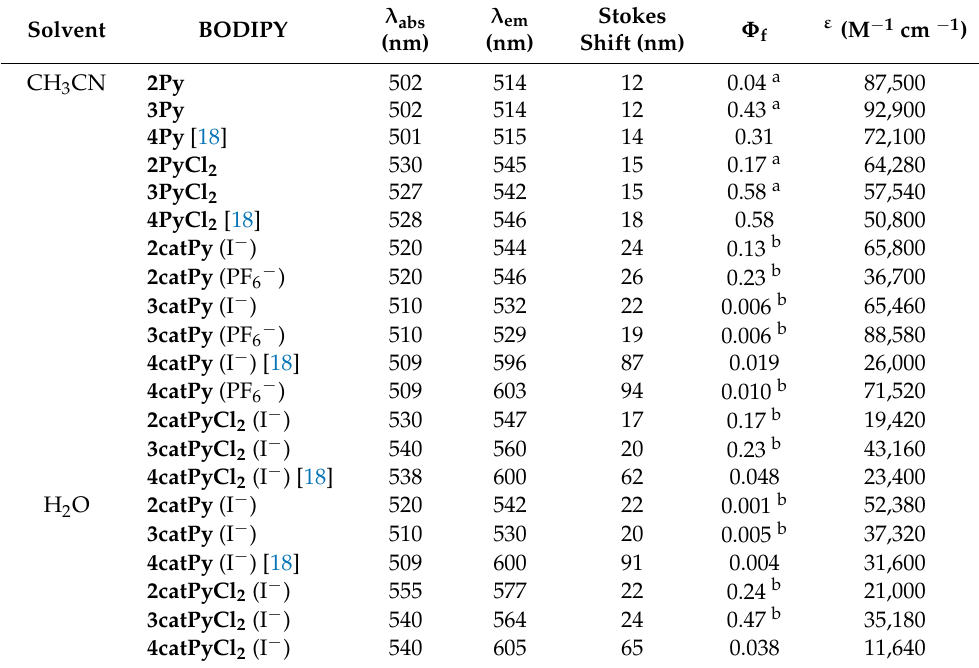
Table 1. Spectroscopic properties of BODIPYs in CH 3 CN and H 2 O and relative fluorescence quan- tum yields.